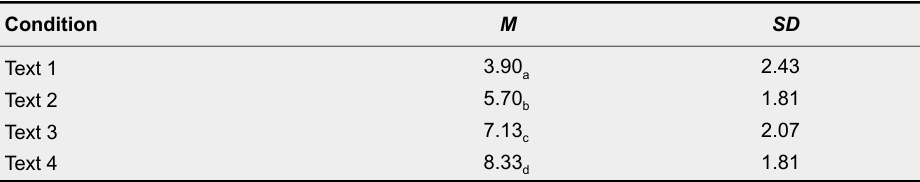
Descriptive Statistics for the Combined Extremity and Absurdity Ratings in Pilot